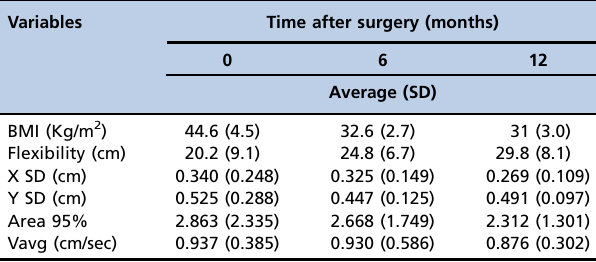
Table 1 - Average and standard deviation of Body Mass Index, flexibility, X standard deviation, Y standard deviation, 95% area under the curve and Vavg at the time of surgery (time 0), 6 and 12 months after